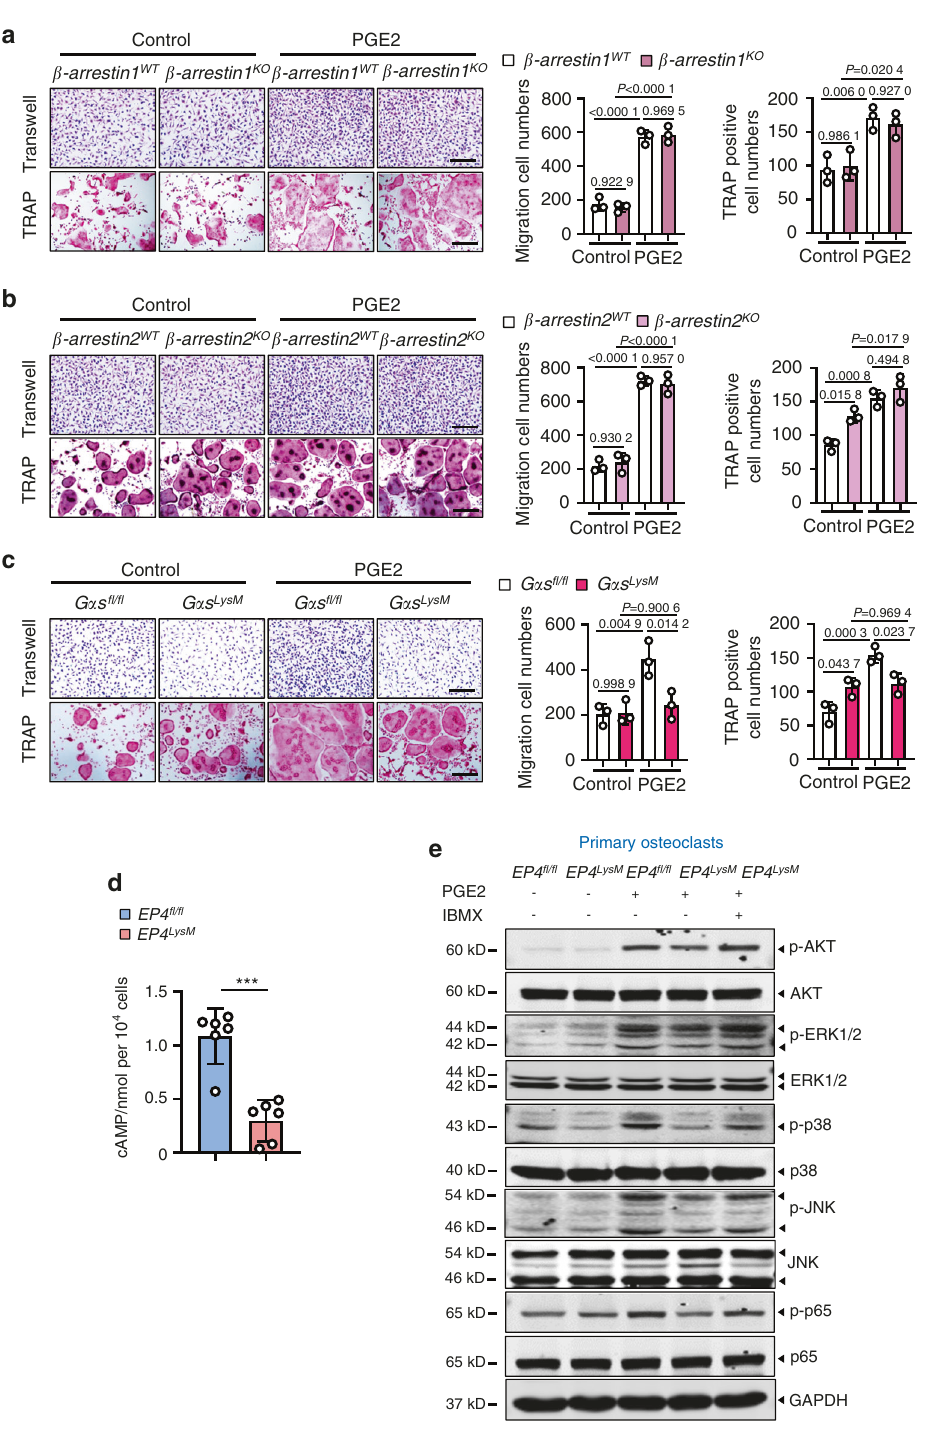
Fig. 8 PGE2 regulates migration and osteoclast differentiation through the G α s/PI3K/AKT/MAPK signaling pathways downstream of EP4. PGE2 regulates migration and osteoclast differentiation independent of β -arrestin1 ( a ) and β -arrestin2 ( b ) but via G α s ( c ). BMMs from the WT and littermate β -arrestin1- and β -arrestin2- knockout mice were used to generate osteoclasts by stimulation with 10 ng·mL − 1 M-CSF and 50 ng·mL − 1 RANKL and incubation with 100 nmol·L − 1 PGE2. For G α s experiments, osteoclasts were generated from the GMMs of the G α s fl / fl controls and G α s fl / fl ; LysM-cre ( G α s LysM ) mice. A differentiation assay (TRAP staining) (left) and the corresponding quantitative analysis (right). Scale bars, 50 μ m. Error bars are the mean ± s.d. n = 3. Two-way ANOVA followed by Tukey ’ s t tests. Scale bars, 50 μ m. d cAMP production was measured via ELISAs for osteoclasts derived from the Ep4 fl / fl and Ep4 LysM mice. BMMs from the two mouse strains were isolated and stimulated with 10 ng·mL − 1 M-CSF and 50 ng·mL − 1 RANKL to differentiate into osteoclasts and incubated with 100 nmol·L − 1 PGE2 for 30 min prior to cAMP measurements. Error bars are the mean ± s.d. *** P < 0.001 by unpaired two-tailed Student ’ s t test. The experiment was performed with three biological replicates. e Representative images of the indicated protein expression by western blotting for osteoclasts generated using BMMs of Ep4 fl / fl and Ep4 LysM mice. The cells were treated either with osteoclastogenic media (10 ng·mL − 1 M-CSF and 50 ng·mL − 1 RANKL) alone, with PGE2 (100 nmol·L − 1 ), or PGE2 with IBMX (1 mmol·L − 1 ) for 3 h. The experiments were performed with three biological